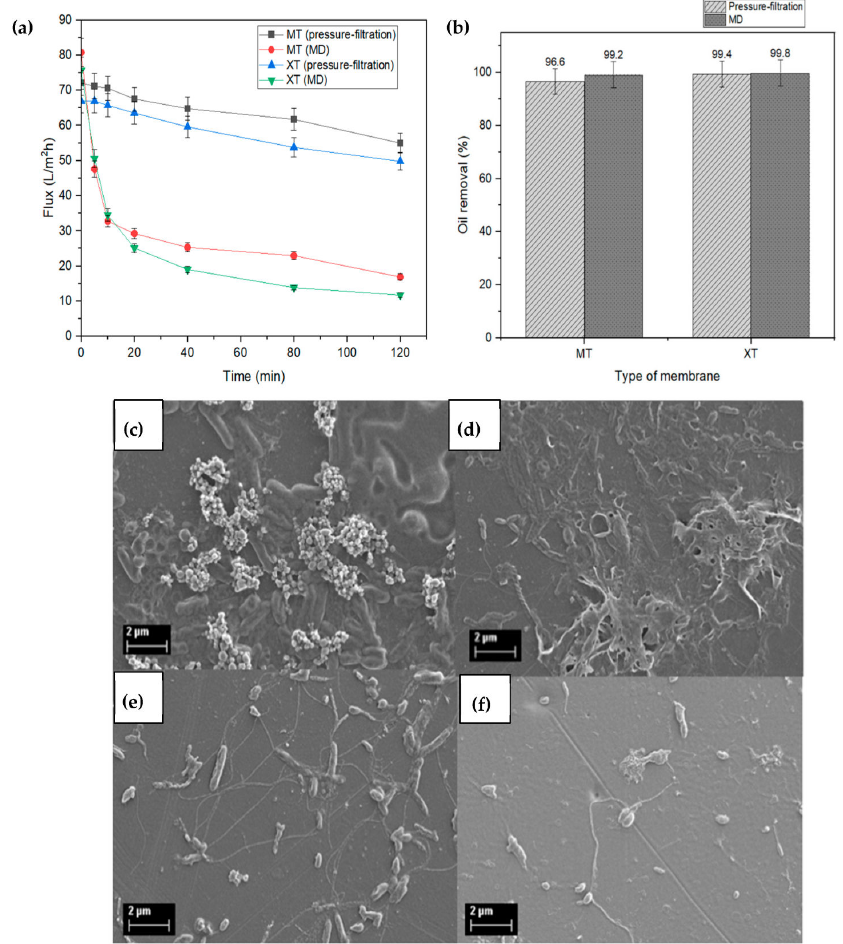
Figure 8. ( a ) Flux performance and ( b ) the oil removal percentage of MT and XT membranes in treating OW using pressure-filtration and MD methods. The FESEM images of MT and XT membranes after ( c , d ) pressure-filtration and ( e , f ) MD